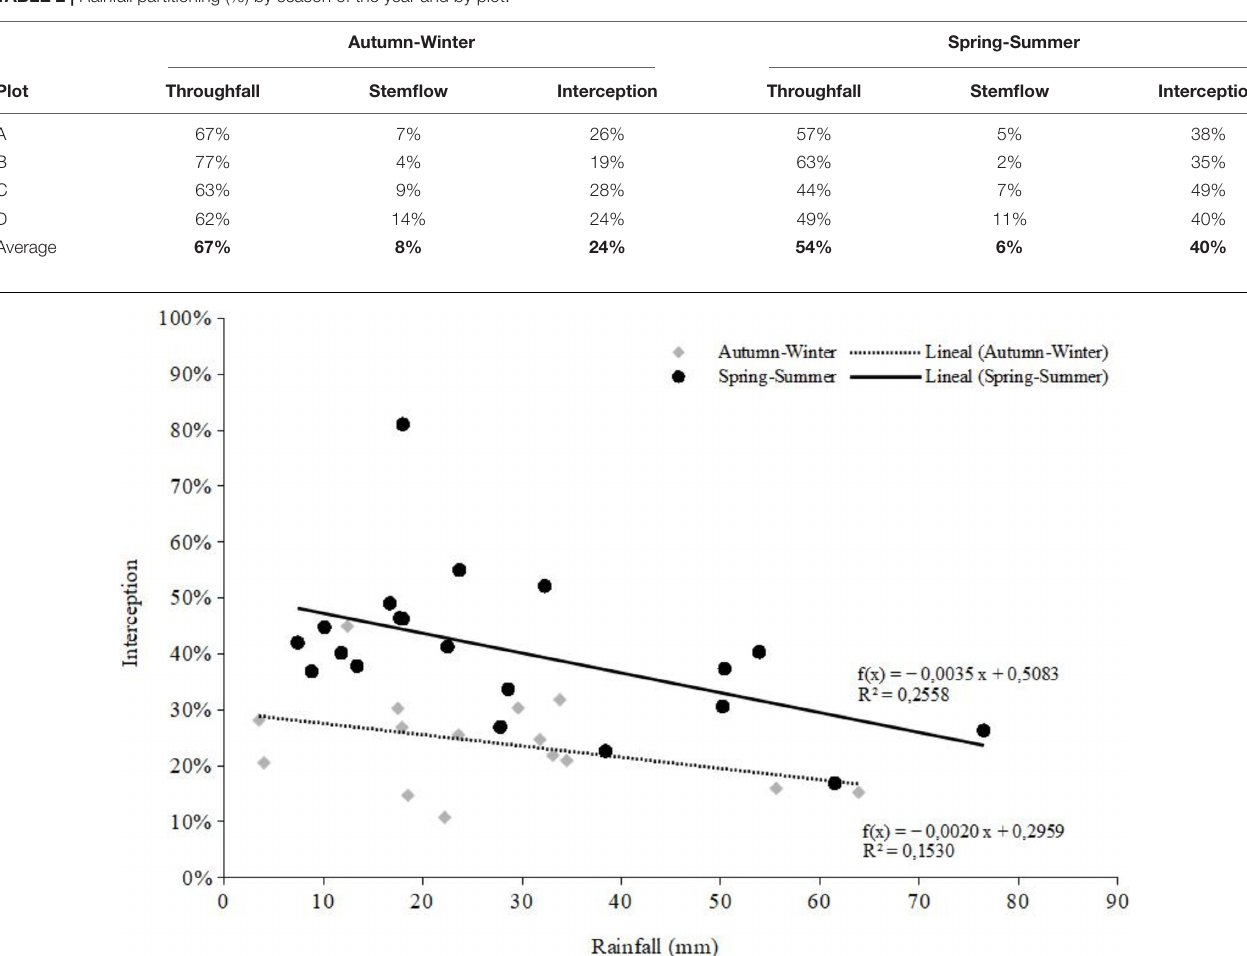
TABLE 2 | Rainfall partitioning (%) by season of the year and by plot.